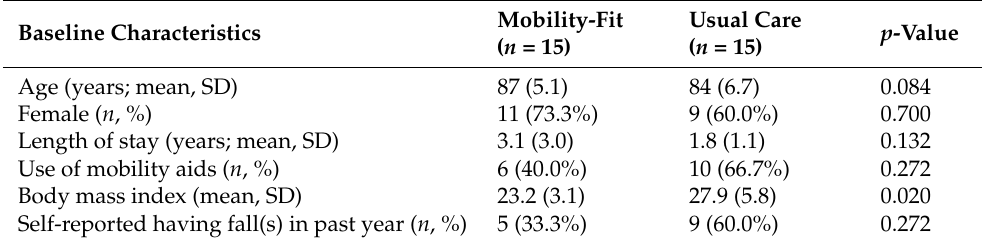
Table 1. Baseline characteristics of participants in Mobility-Fit and Usual Care groups. Baseline